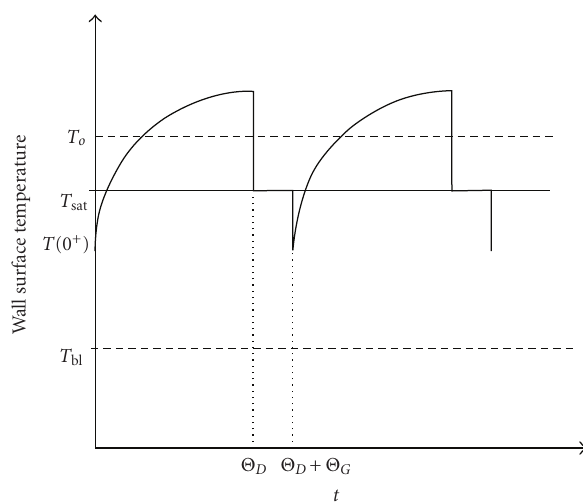
Figure 2: Surface temperature oscillations in the wall during the ebullition cycle.